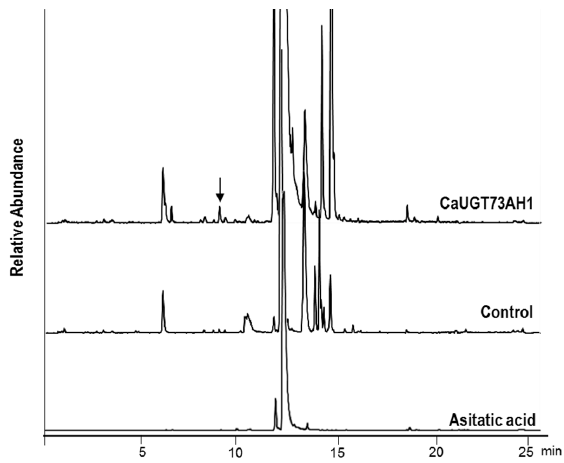
Figure 5 . UPLC-QTOF/MS analysis of the products from glycosylation assays of UGT73AH1. Extracts from incubation mixtures containing the protein together with asiatic acid and UDP-glucose are compared with a boiled-protein control and authentic asiatic acid standard. The narrow indicates a peak in the protein incubation extract not present in the control and standard traces. The mass spectral identification of this peak is shown in Figure 6.